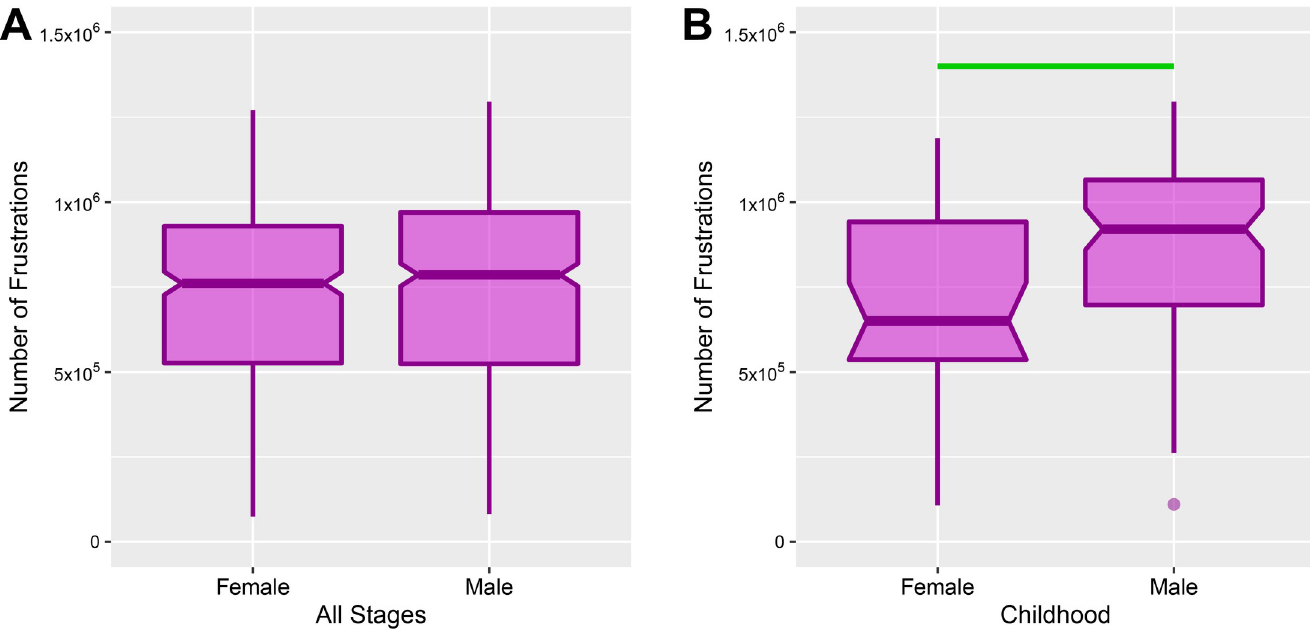
Fig 5. Gender differences in requirement to change of functional brain network. Comparisons of the number of frustrations between male and female subjects of all subjects disregarding lifespan stages (A) and children (B) . The notched regions of boxes indicate median and 95% confidence interval of the median and green horizontal line denotes between gender significant difference for childhood stage (p-value �